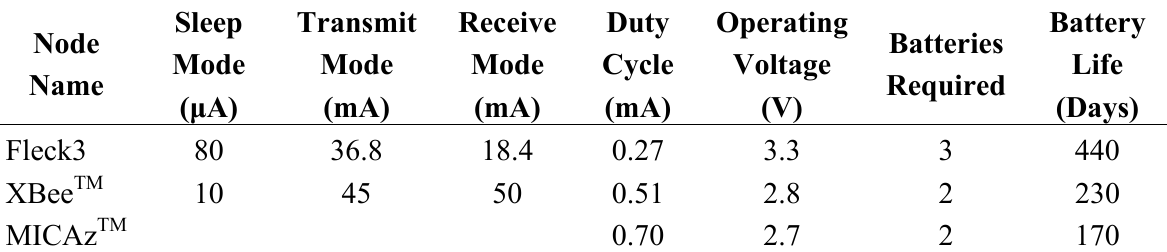
Table 1 . Consumption parameters for some example wireless sensor nodes